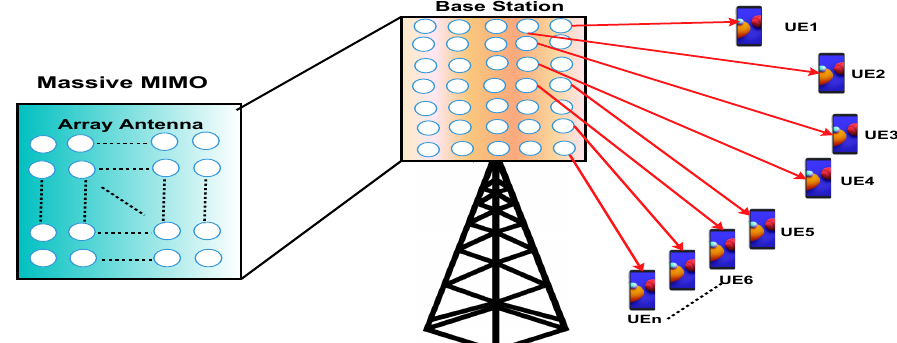
Figure 2. Pictorial representation of multi-input and multi-output